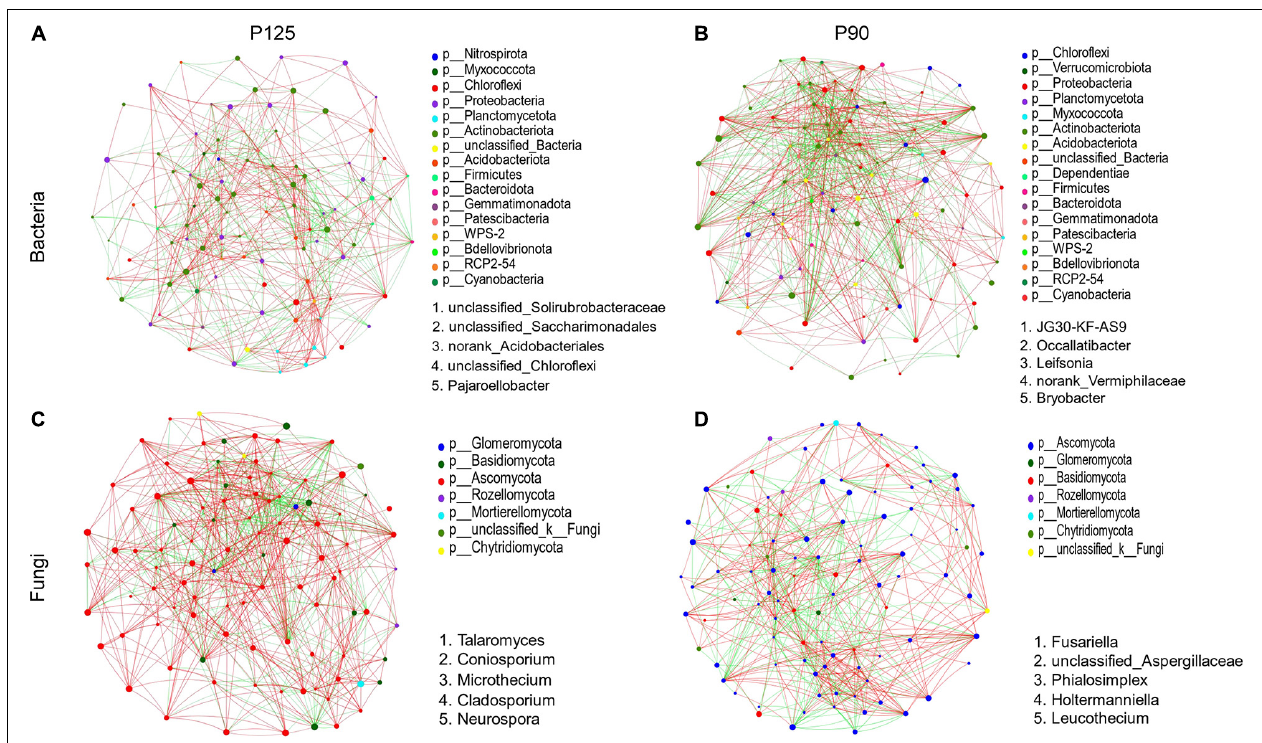
FIGURE 5 | (A–D) Network analysis showing the connectedness among genera of bacteria or fungi in the soils under P125 (A,C) and P90 (B,D) . Nodes ( colored dots ) imply the genera involved in the networks, and the size of the node indicates the abundance of species. Links mean the relationship among the nodes: Red and green lines represent positive and negative correlations, respectively. Dots of different colors indicate the different phyla to which the genera belong. The keystone genera are based on the top five betweenness centrality scores in the